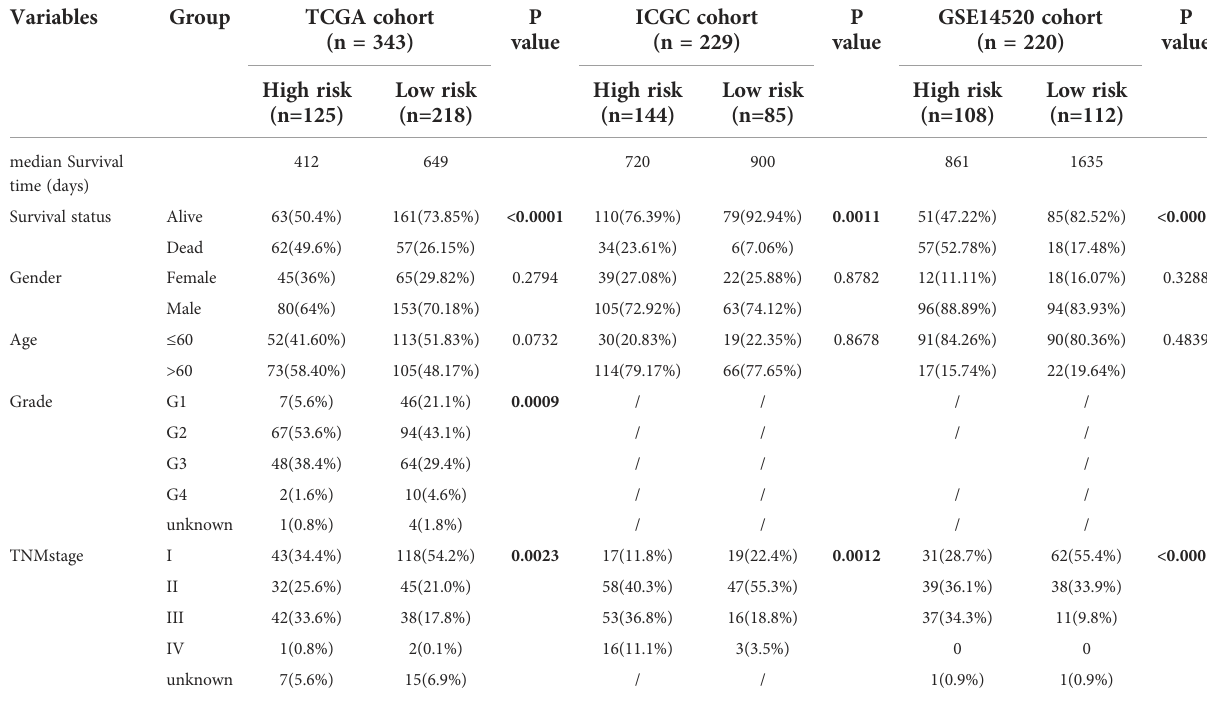
TABLE 1 Baseline characteristics of the patients in different risk groups of three